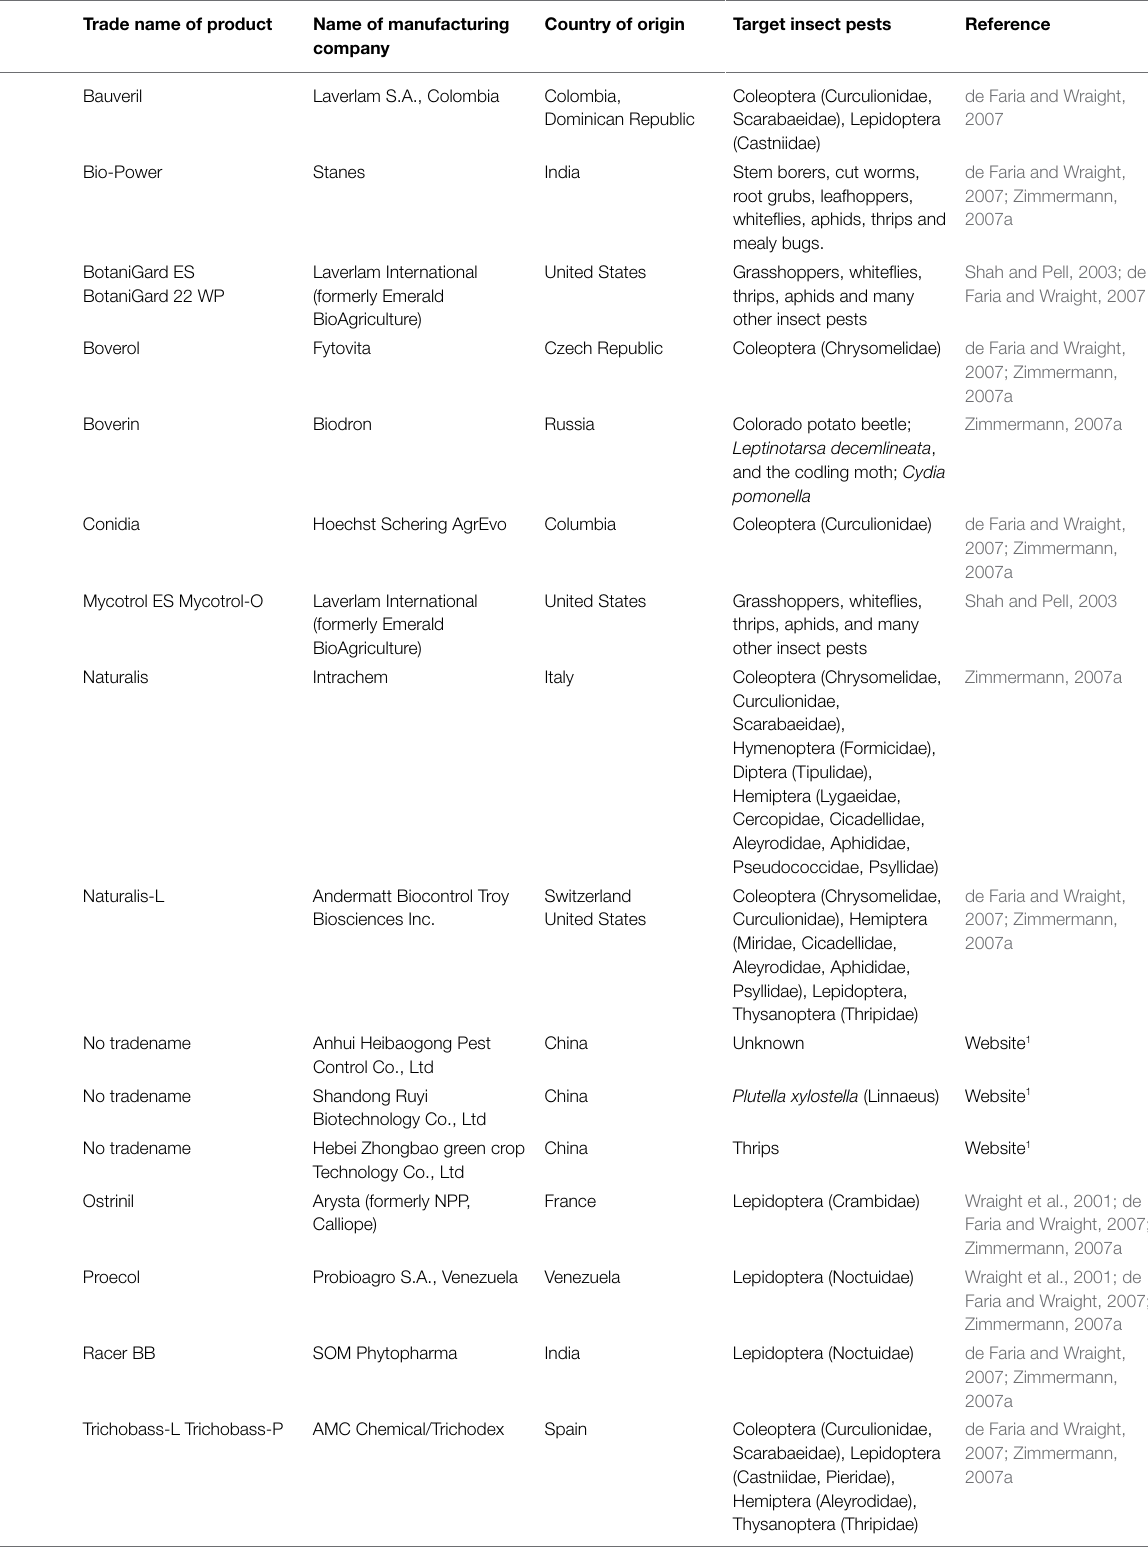
TABLE 1 | Some of the common mycopesticides that have been formulated and registered for use as alternatives to chemical pesticides.